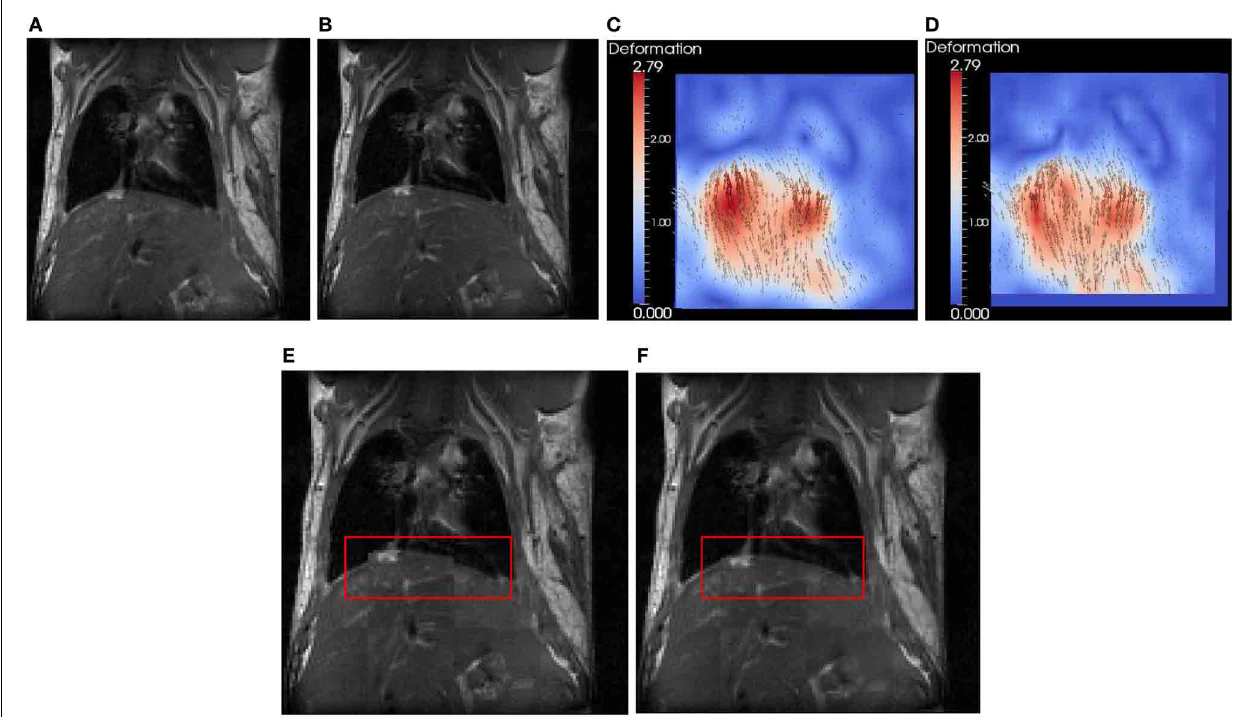
FIGURE 4 | Synthetic evaluation of FEMScatteredDataPointSetToImage Filter. (A) the undeformed lung image, (B) the deformed lung image according to (C) , (C) the deformation field image (ground truth), (D) the estimated